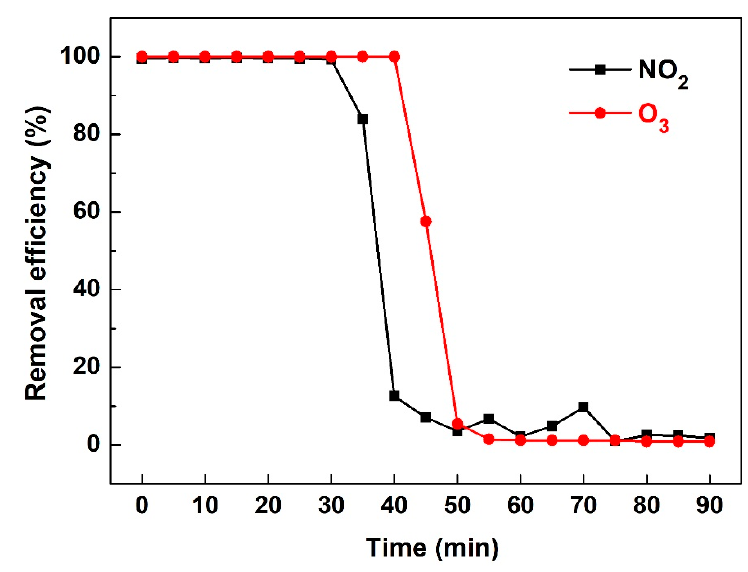
Figure 9. Elimination of NO 2 and O 3 using Na 2 SO 3 absorption (0.5%, wt%).